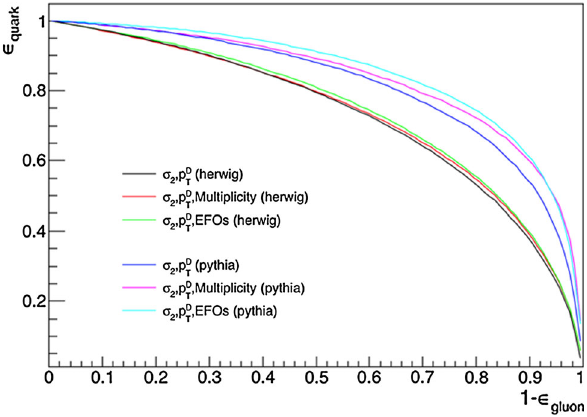
Fig. 5 ROC curves for BDT discriminators constructed from various combinations of observables, as indicated by the legend, for events showered using both Herwig and Pythia with jet p T ≥ 100 GeV. The discrimination is superior in Pythia. We see in both event generators that including the EFOs rather than multiplicity (which is used in the CMS tagger) yields a marginally better